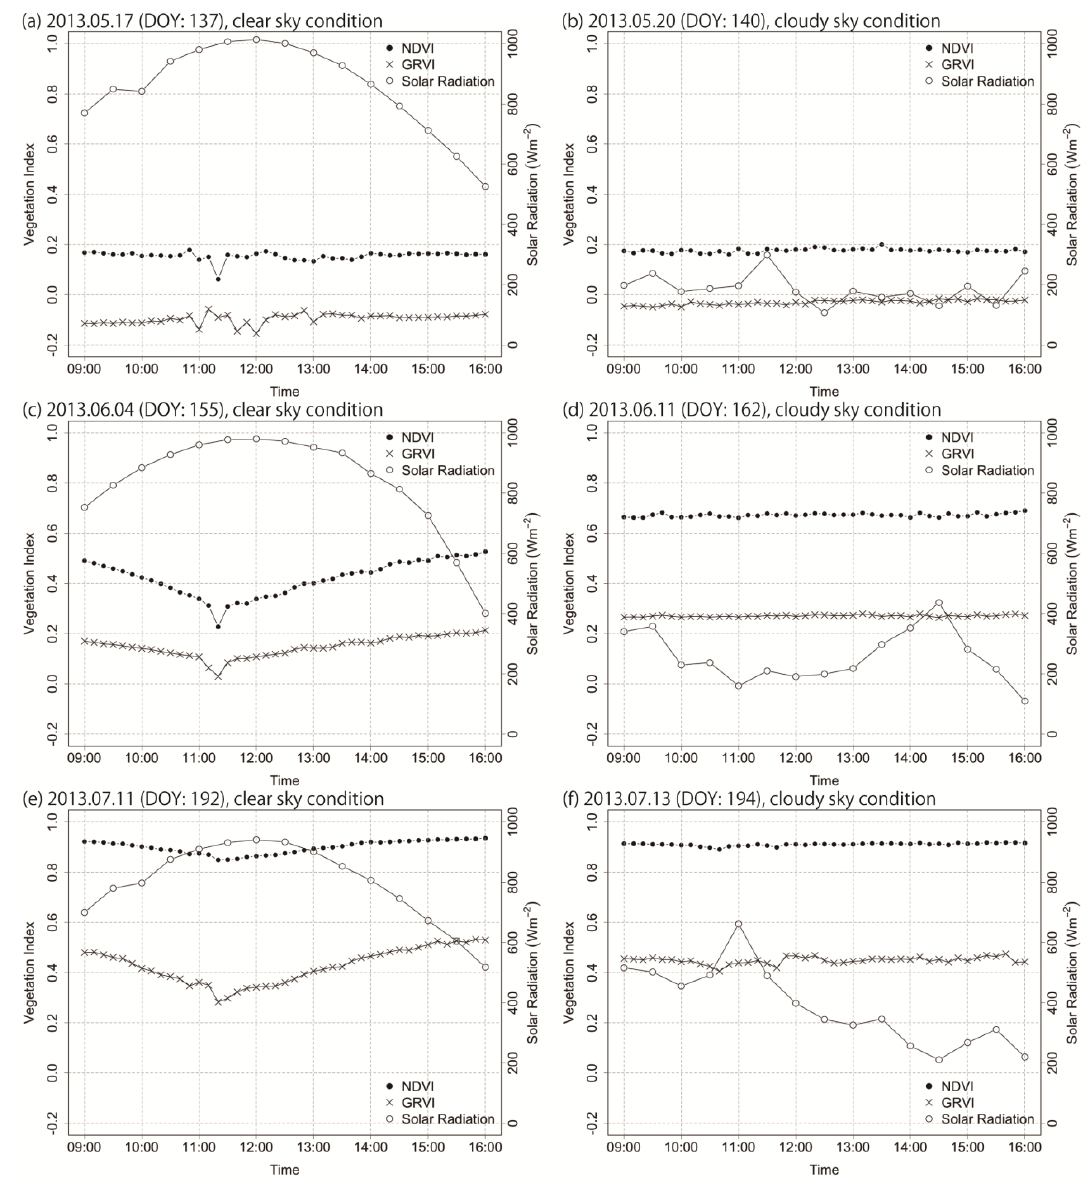
Figure 2. Distinctive diurnal changes of the NDVI and the GRVI under clear sky conditions ( left ) and cloudy sky conditions ( right ) at the rice site. Solar noon is between 11:36 and 11:45 local time. ( a ) DOY: 137; ( b ) 140; ( c ) 155; ( d ) 162; ( e ) 192; ( f )